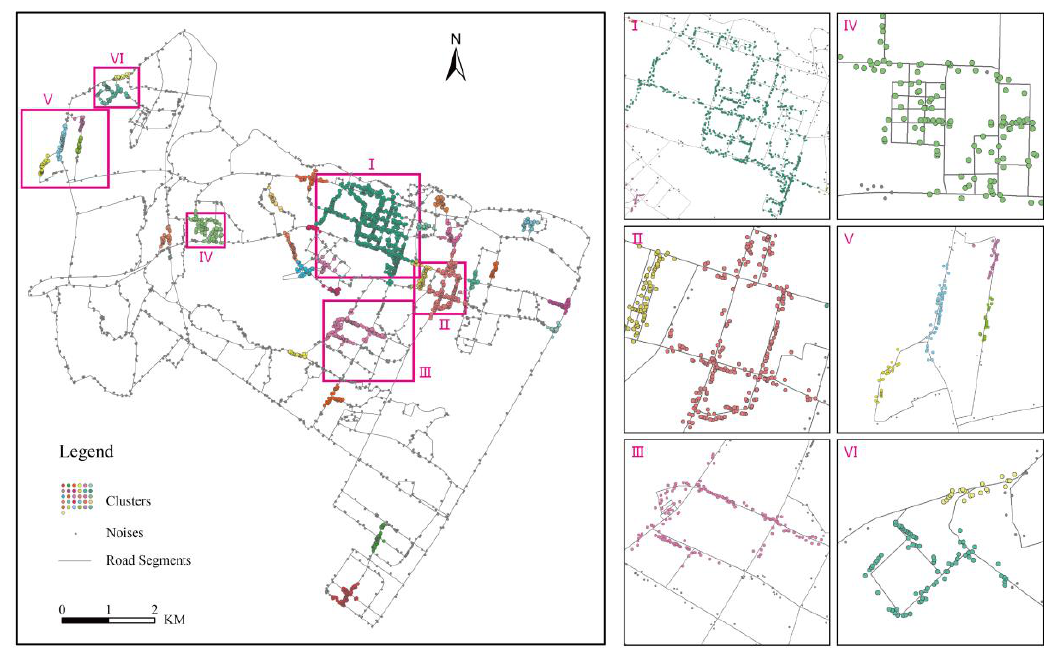
Figure 9. Clusters of NS-DBSCAN algorithm ( eps = 200, MinPts = 20) accurately delineated the six highly populated regions of aggregated POI.